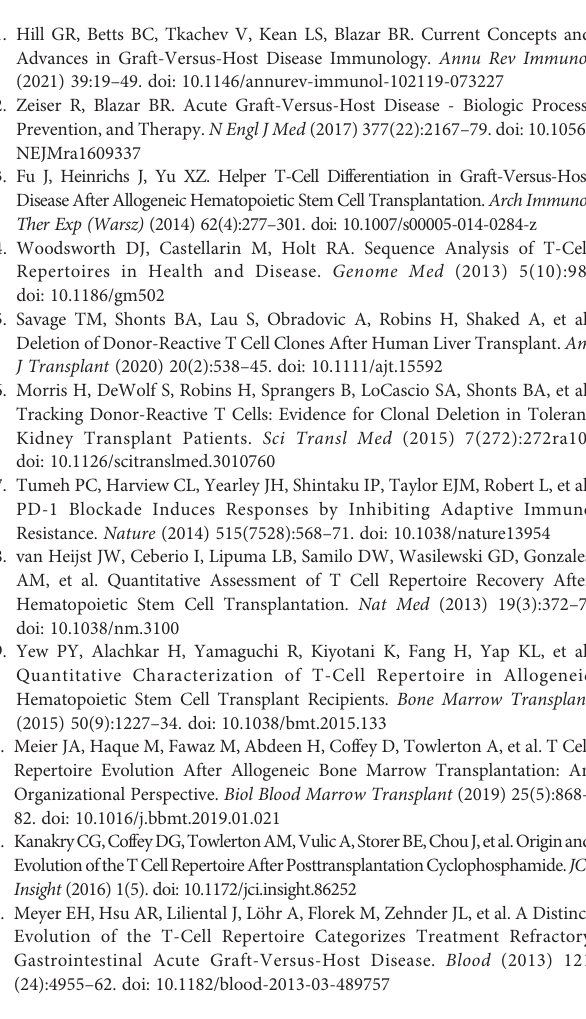
Supplementary Figure 1 | Body weight change and donor T cell engraftment after BMT. Rag1 -/- BALB/c or Rag1 -/- B6 mice were conditioned with total body irradiation (TBI) administered 550cGy (BALB/c) or 750cGy (B6) using an X-RAD 320 X-ray Irradiator. Puri fi ed T cells (1×10 6 ) from CD45.1 + B6 mice together with bone marrow cells (5×10 6 ) isolated form Rag1 -/- B6 were i.v. injected into these recipient mice within 24h after TBI. Recipient body weight are shown (A) .